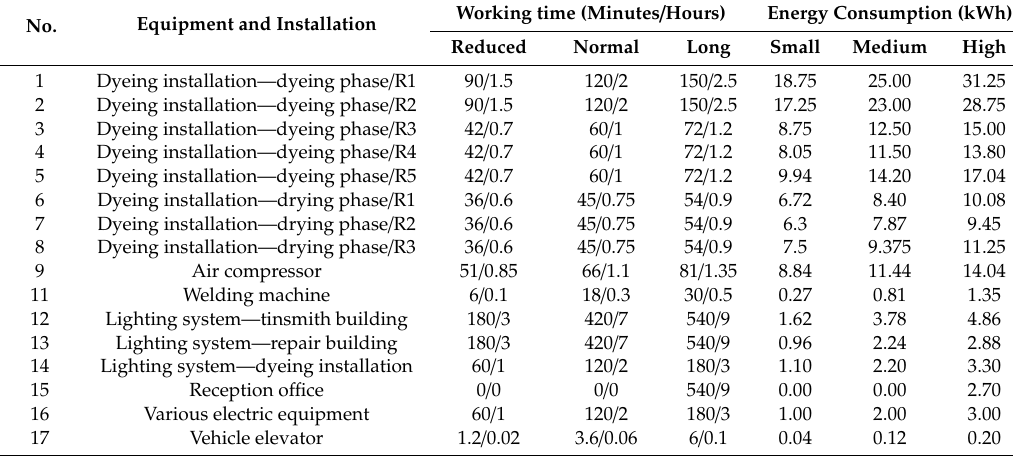
Table 8. The working time and energy consumption of each equipment and installation depending on the intensity of activity.